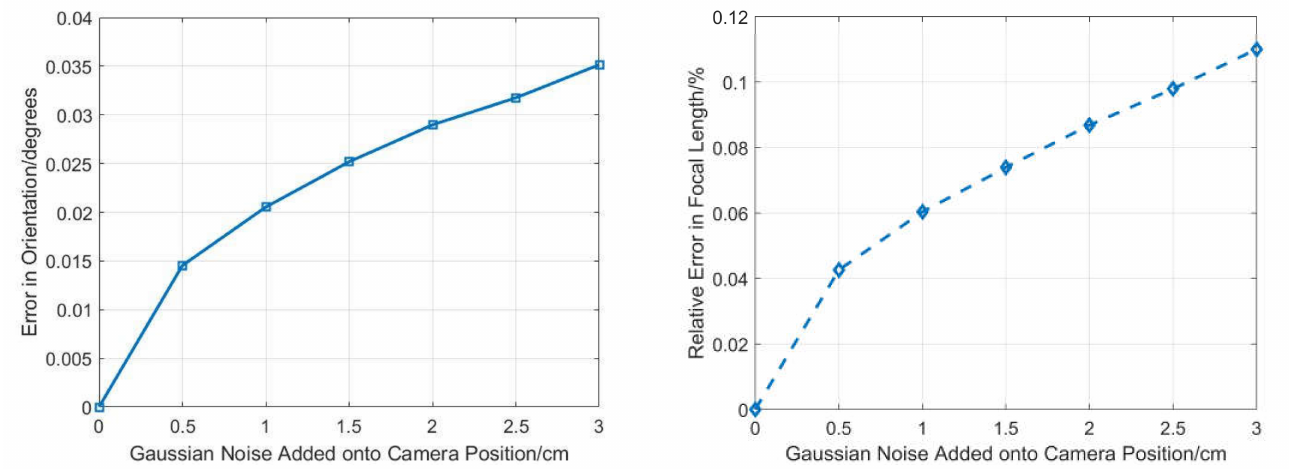
Figure 8. Robustness to camera position noise for orientation ( left ) and focal length ( right